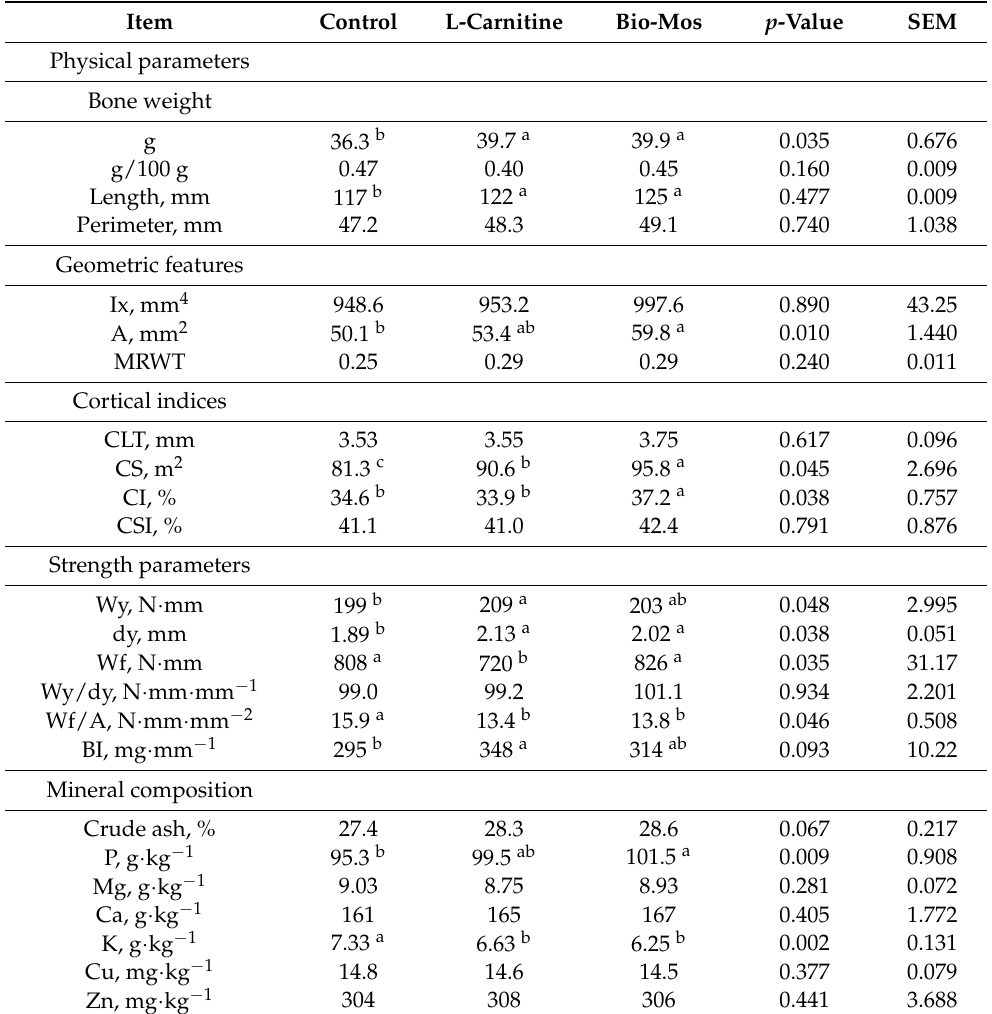
Table 8. Physical, morphometric parameters, strength parameters, and mineral composition of crude ash in female turkey’s femur bones 1